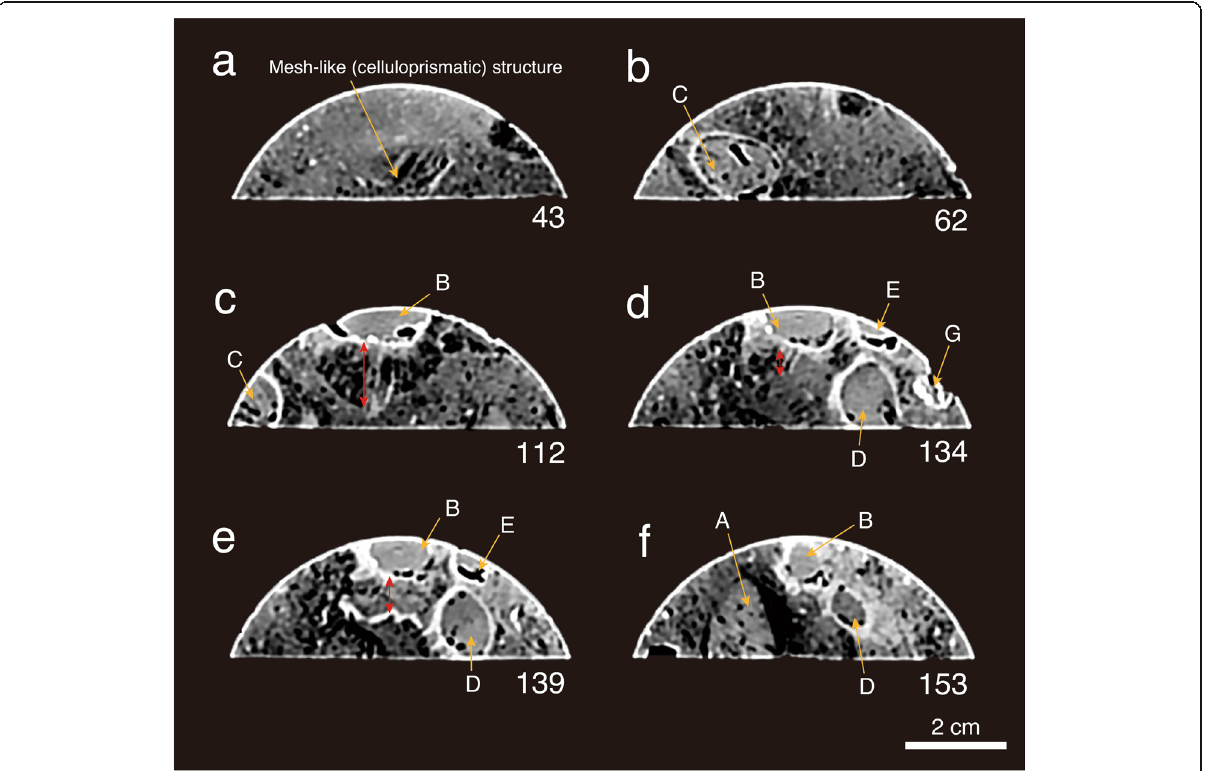
Fig. 4 Horizontal slice images obtained by X-ray CT. a Upper-upper slice (slice number 43 in Fig. 2). Note mesh-like (celluloprismatic) structure in the center. b Upper-middle slice (slice number 62 in Fig. 2). Note rudist C on the left-hand side. c Upper-lower slice (slice number 112 in Fig. 2). Note rudists B and C. d Lower-upper slice (slice number 134 in Fig. 2). Four rudists (rudists B, D, E, and G) are present. e Lower-middle slice (slice number 139 in Fig. 2). Three rudists (rudists B, D, and E) are present. f Lower-lower slice (slice number 153 in Fig. 2). Three rudists (rudists A, D, and B) are discernible. Rudist B possesses the thick outer shell layer (red arrows in c , d , and e ). Yellow arrows in b – f indicate individual